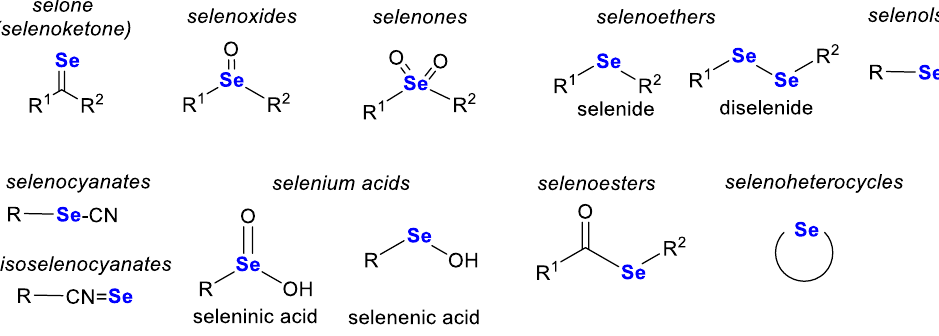
Figure 2. General formulas of major organoselenium compounds [11,13].